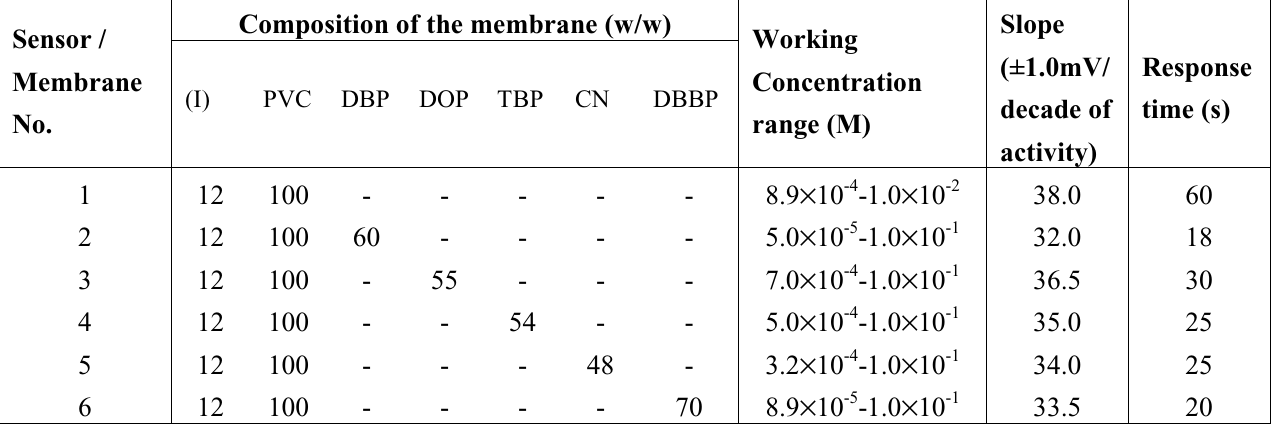
Table 1. Response characteristics of MoO 42- - selective sensors based on TMOPP-Co (I). Composition of the membrane (w/w) Sensor /